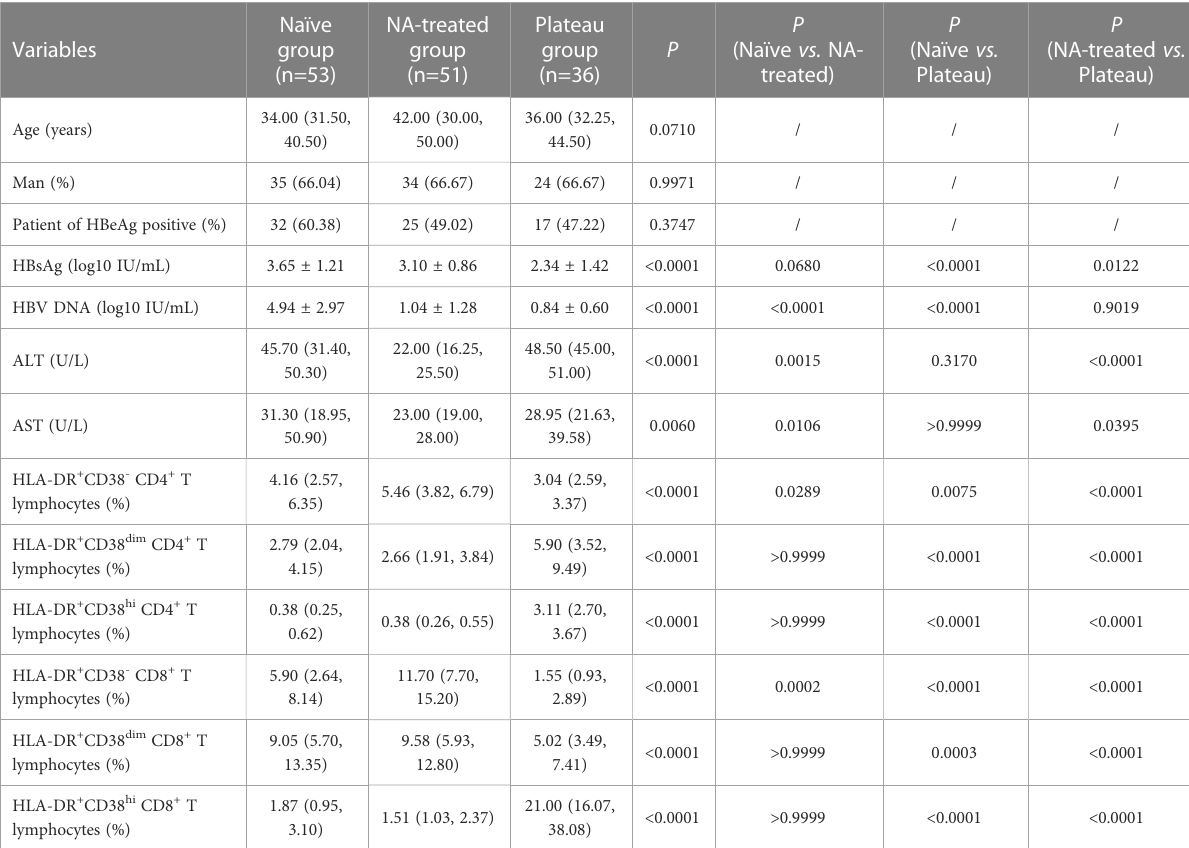
TABLE 1 Comparison of baseline characteristics of the study population a .